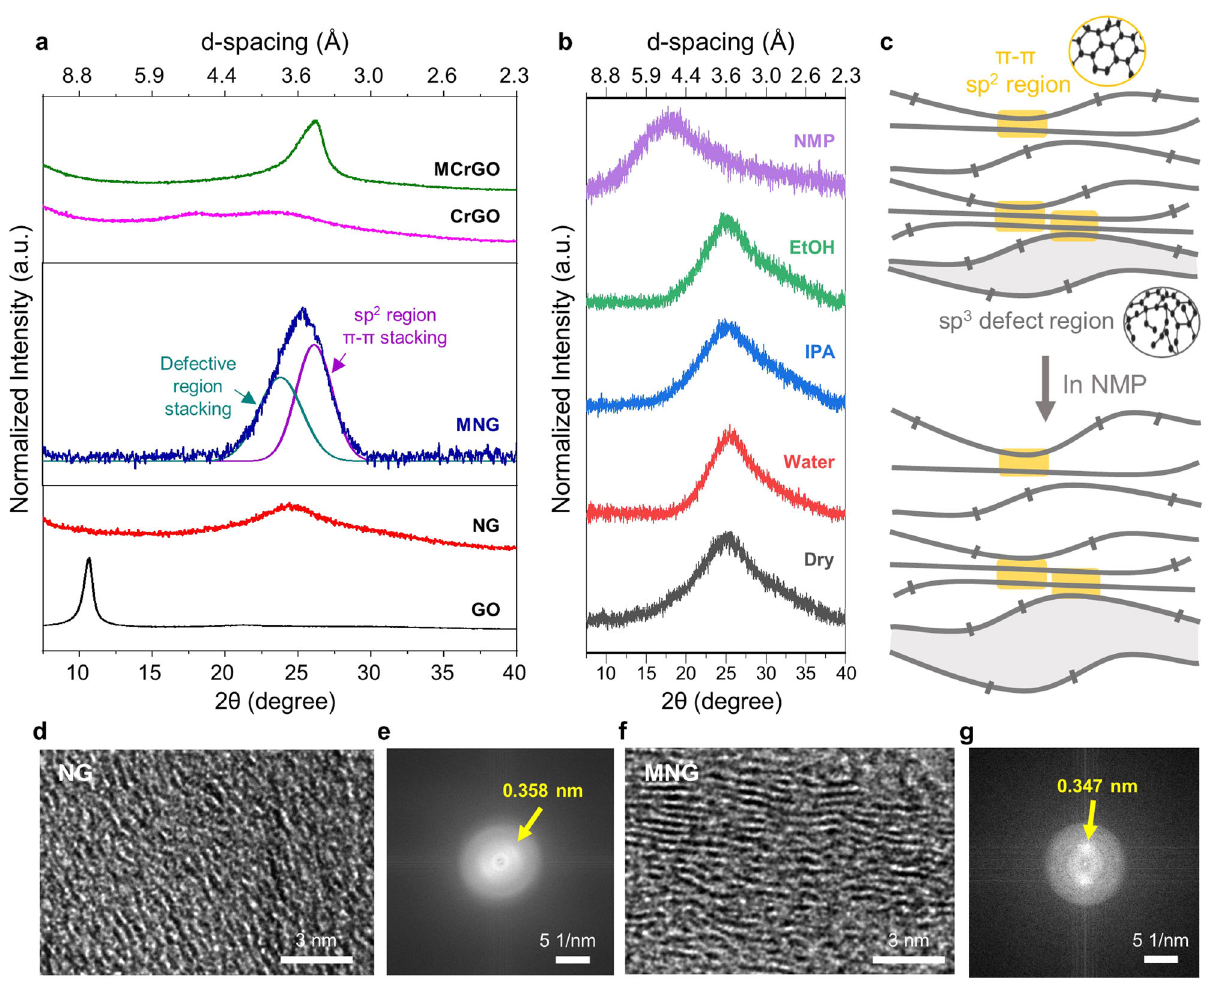
Fig.4|Interlayerstructureofgraphenematerials.a NormalizedXRDpatternsof GO, NG, MNG, CrGO, and MCrGO. b XRD patterns of MNG membrane after immersion in various solvents. c Schematic structure of MNG membrane in dry-